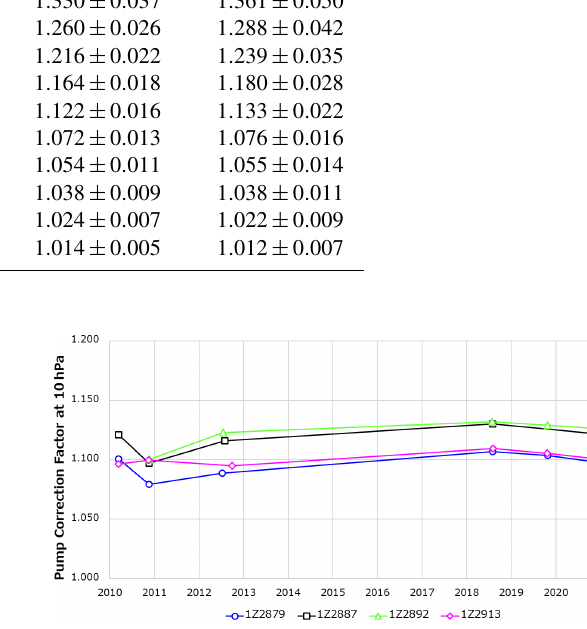
Figure 13. Pump correction factors at 10hPa determined with the same four sensors from 2010 to